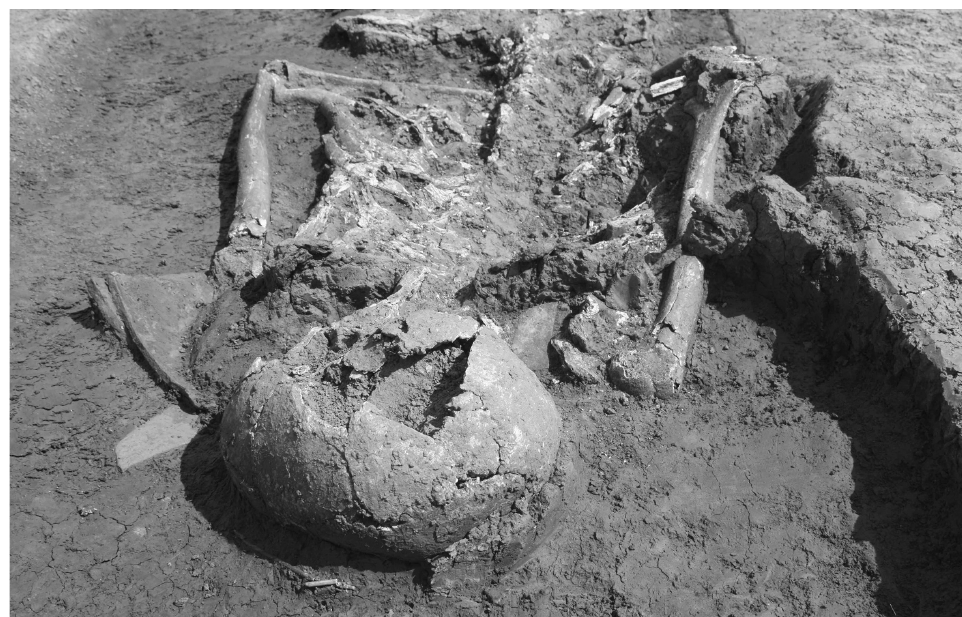
Figure 7: Carbonara Scrivia, tomb no. 1. Detail of the restriction system with the nails (photo Andrea Martelli © Soprintendenza Archeologia del Piemonte).